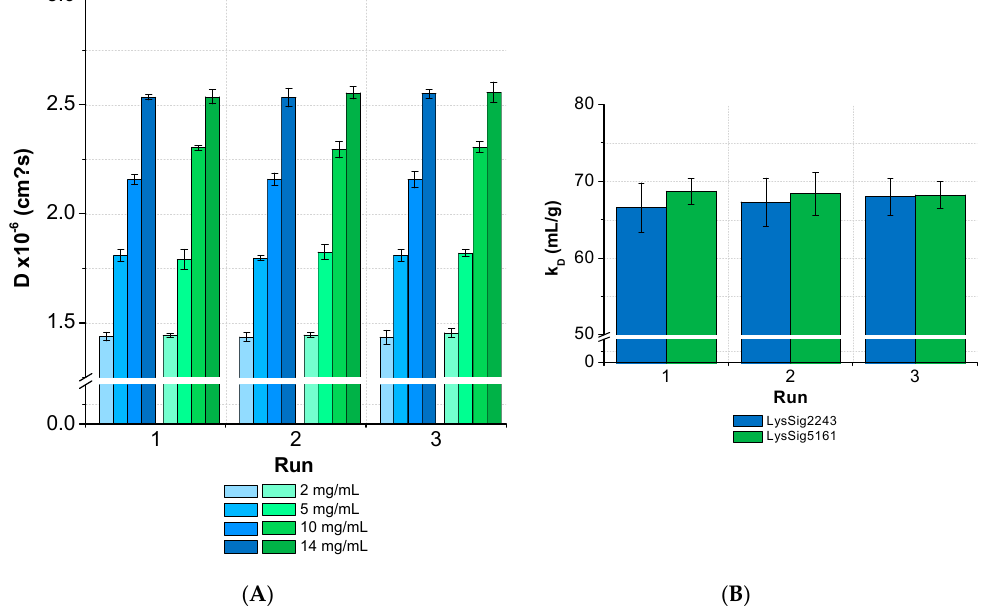
Figure 9. Statistical evaluation (inter-plate CV ) with regards to ( A ) diffusion coefficients collected for two lysozyme batches (LysSig2243: blue and LysSig5161: green), 4 concentrations, 5 replicates, and 3 runs. The plate design is shown in Figure 2. ( B ) The k D obtained from the D of 4 concentrations (2, 5, 10, and 14-mg/mL lysozyme) and 5 replicates at 3 plate positions collected in 3 separate runs (9 total k D of each batch).